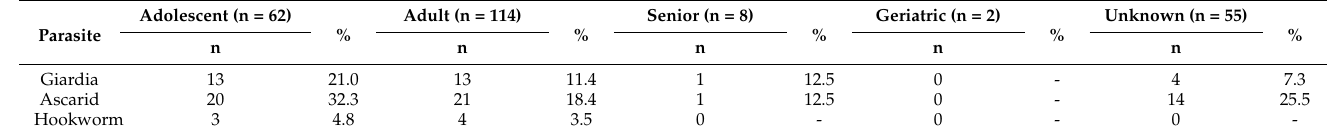
Table 4. Prevalence of parasites detected in the different age categories of cats.